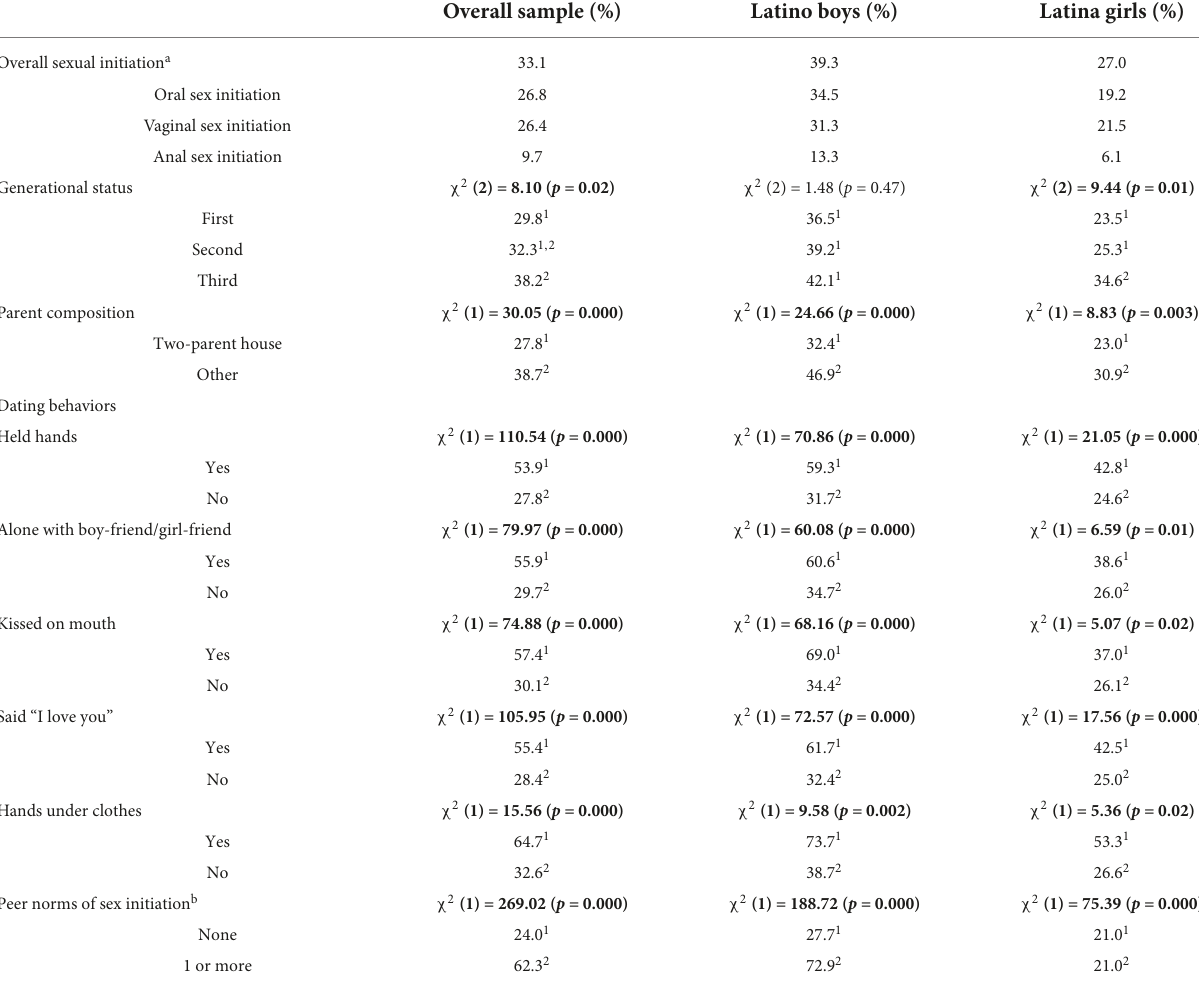
TABLE 2 Prevalence of sexual intercourse (oral, vaginal, and anal) initiation by demographic and categorical predictors. Overall sample (%) Latino boys (%) Latina girls (%) Overall sexual initiation